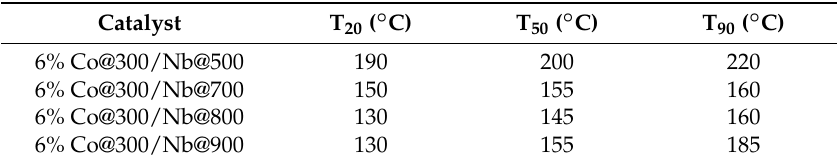
Table 1. Six percent Co@300/Nb with the number following @ = pre-calcination temperatures of the carrier for CO oxidation .